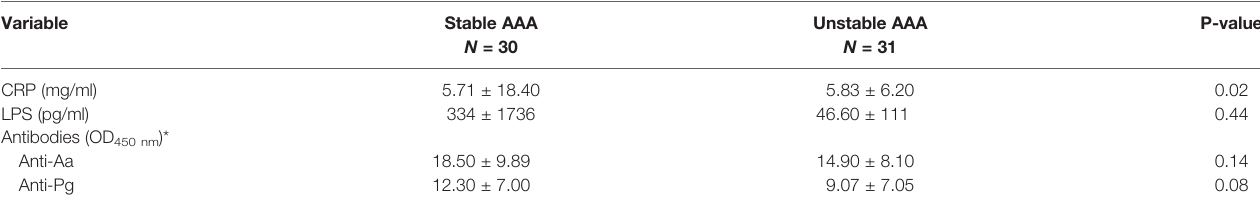
TABLE 2 | Blood markers analysis of study patients with stable or unstable AAA.